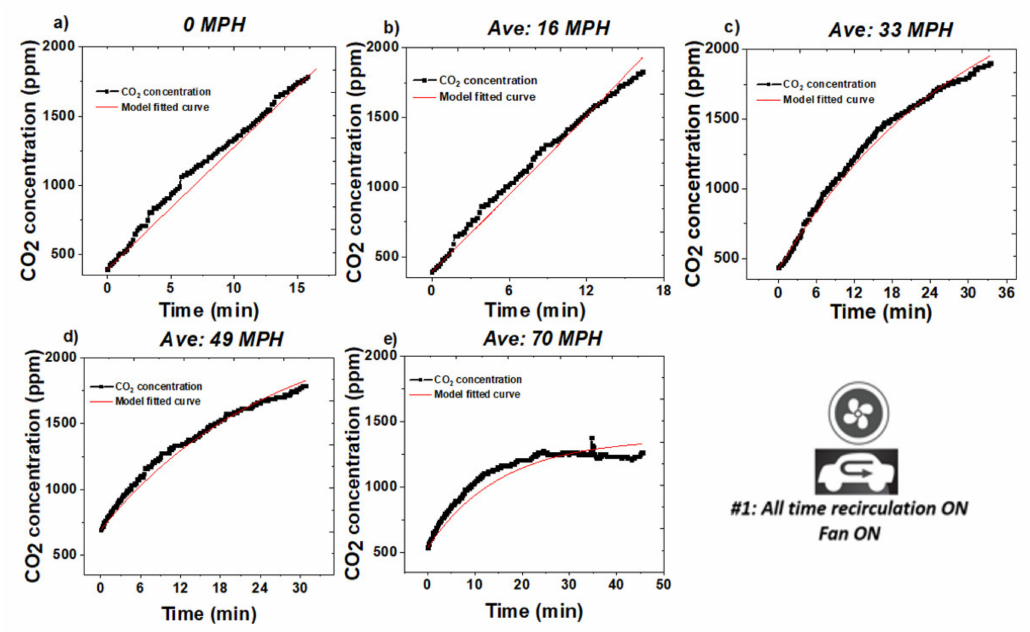
Figure 2. CO 2 concentration inside the vehicle cabin under di ff erent driving speed, all-time recirculation (RC) on mode. ( a ) 0 MPH (parked); ( b ) 16 MPH; ( c ) 33 MPH; ( d ) 49 MPH; ( e ) 70